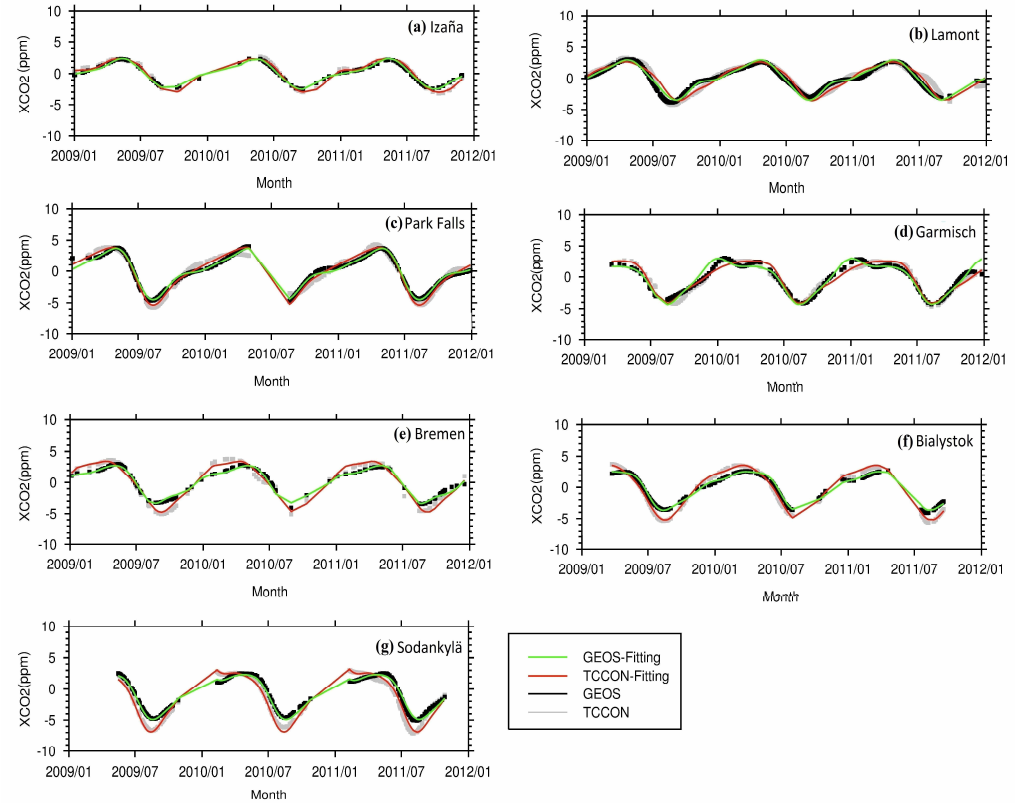
Figure 12. Seasonal cycles of XCO 2 are compared for GEOS-Chem and TCCON in the Northern Hemisphere during 2009–2011, which is calculated by removing the long-term trends of XCO 2 (gray dots for TCCON, black dots for GEOS-Chem); smoothed lines is fitting seasonal cycle (red for TCCON, green for GEOS-Chem).